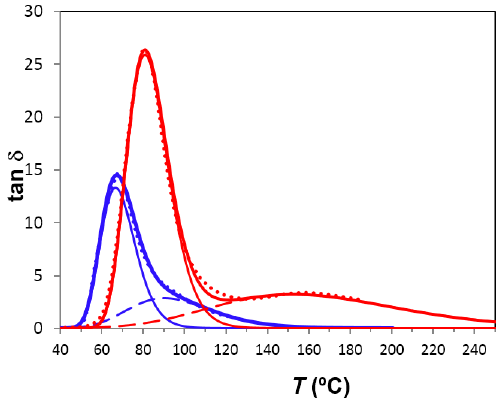
Figure 12. Deconvolution of the dielectric relaxation spectroscopy curves for PEI2000-PLA5 (blue), PEI2000-PLA20 (red): experimental curves (dotted lines); fit (thick lines), deconvoluted into α -relaxation (thin lines) and α′ -relaxation (dashed lines). Frequency: 0.1 Hz. Heating rate: 0.5 °C/min. (5) PEI800-PLA5